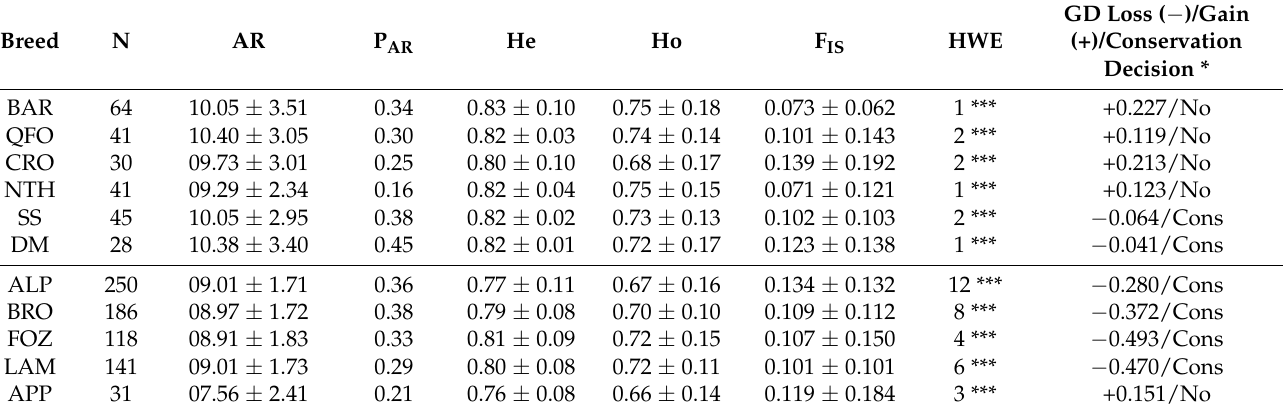
Table 3. Genetic diversity estimates in Tunisian-Italian corridor’s local sheep breeds. (N), number of analyzed samples; (AR), allelic richness obtained with the rarefaction method; (P AR ), allelic richness of private alleles; (He), expected (Ho), observed heterozygosity, within-breed heterozygote deficiency (F IS ); (HWE), number of loci deviated from the Hardy–Weinberg equilibrium; GD (Loss/Gain), proportional loss or gain in global genetic diversity after hypothetically removing each breed and relative conservation